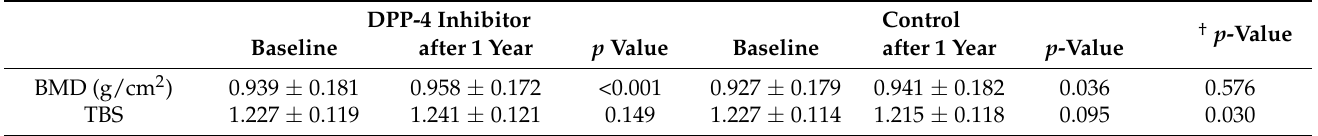
Table 2. Changes in the BMD and TBS during the follow-up